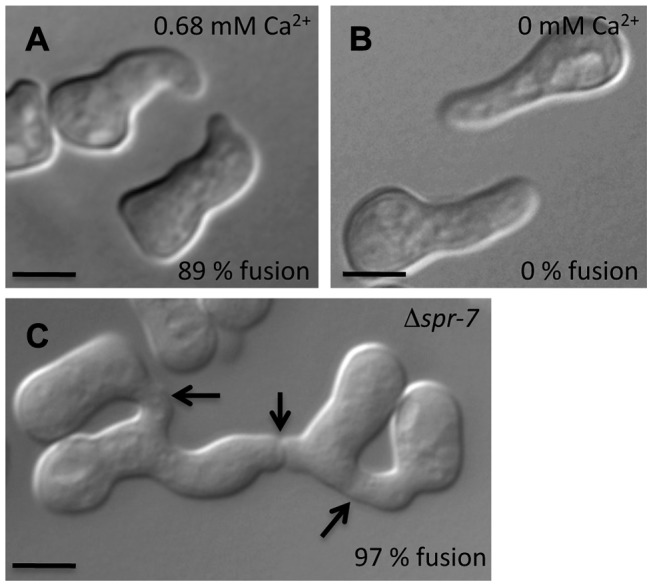
Conidial germling fusion phenotypes.(A) Representative micrograph of wild-type (FGSC 2489) germlings undergoing chemotropic interactions in standard laboratory medium (0.68 mM Ca2+) [71]. (B) Representative micrograph of failure of chemotropic interactions and cell fusion in wild type (FGSC 2489) germlings in standard laboratory media lacking Ca2+. Fusion frequencies from large-scale replicate analyses are in black text at the lower right of each image. (C) Germlings bearing a deletion in spr-7 involved in multiple germling fusion events. Arrows indicate fusion points. Scale bar = 5 µm.